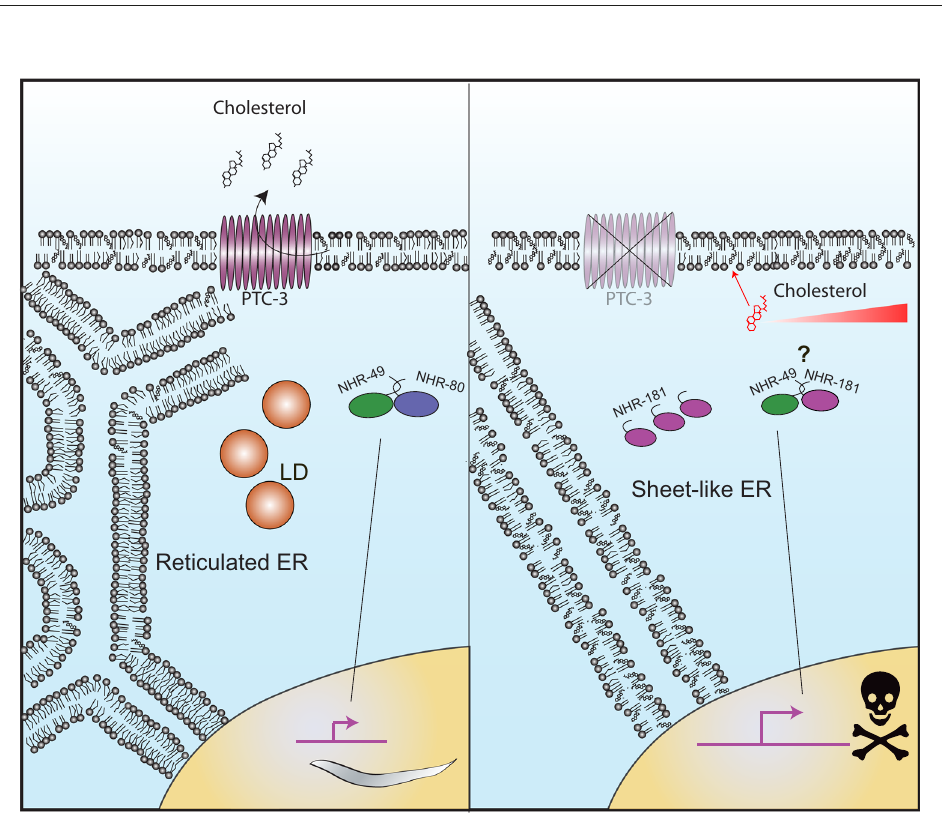
Fig. 6 PTC-3 in fl uences NHR function in a cholesterol-dependent manner. A Overexpression of NHR-49 or FAT-7 partially rescues ptc-3(RNAi) defects. Representative DIC images of worms. Scale bars 100 µ m. B Quanti fi cation of survival rate upon overexpression of FAT-7, NHR-49 or NHR-80 in ptc-3 (RNAi) animals. Mean and SD error bars. FAT-7 *** p = 0.0004, NHR-49 *** p = 0.0001. ( C ) Over expression of NHR-49 partially restores fat accumulation in ptc-3(RNAi) animals. Nile Red staining. Scale bars 20 µ m. ( D ) Quanti fi cation of data shown in ( C ) * p = 0.0496 n = 11 (Mock N2), 21 (Mock; NHR-49 OE), 12 ( ptc-3(RNAi ) N2) and 15 ( ptc-3(RNAi ) NHR-49 OE) animals from 3 independent experiments. Mean and SEM error bars. E Schematic representation of ribosomal footprints of mRNA during C. elegans larval development. Oscillatory changes in mRNA levels during developmental time. The timing, amplitude, and whether a gene is oscillating is gene speci fi c. F PTC-3, but not NHR-49 or NHR-80, expression oscillates during development. Data plotted from 46 . G Ribosomal footprint oscillations of NHR-181, NHR-168, and NHR-41 are similar to PTC-3 (data from ref. 46 ). ( H ) NHR-181 expression is modulated dependent on cholesterol levels. qRT-PCR analysis of NHR-41, NHR-168, and NHR-181 in the presence or absence of cholesterol in the growth medium. Mean and SEM error bars. NHR-41 ** p = 0.004 * p = 0.0144, NHR-181 ** p = 0.0011. I Genetic interaction between PTC-3 and NHR-181. Knockdown of NHR-181 rescues ptc-3(RNAi) lethality. Error bars are SEM * p = 0.0496 n = 244 (Mock; ptc-3(RNAi )) and 164 ( nhr-181(RNAi) ; ptc-3(RNAi )) animals from three independent experiments. J nhr-181(RNAi) partially restores fat accumulation in ptc-3(RNAi) animals. Nile Red staining. Scale bars 20 µ m. K Quanti fi cation of data shown in ( J ) * p = 0.0306 n = 19 (Mock; ptc-3(RNAi )) and 18 ( nhr-181(RNAi) ; ptc-3(RNAi )) animals from three independent experiments. Mean and SD error bars. Statistical source data are available as source data.